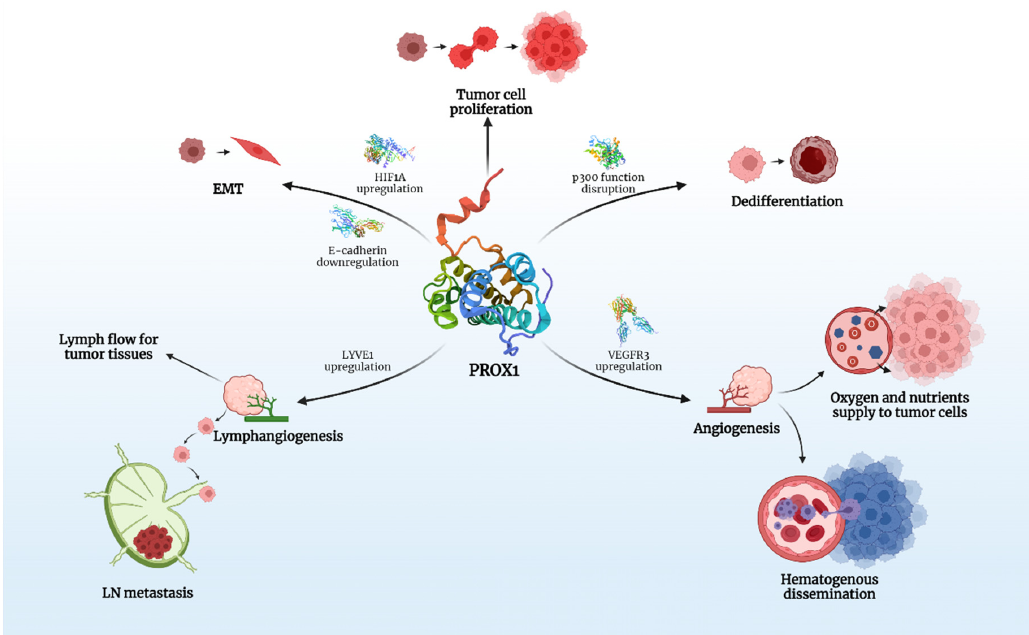
Figure 1. The key roles of PROX1 in carcinogenesis. Created with BioRender.com.